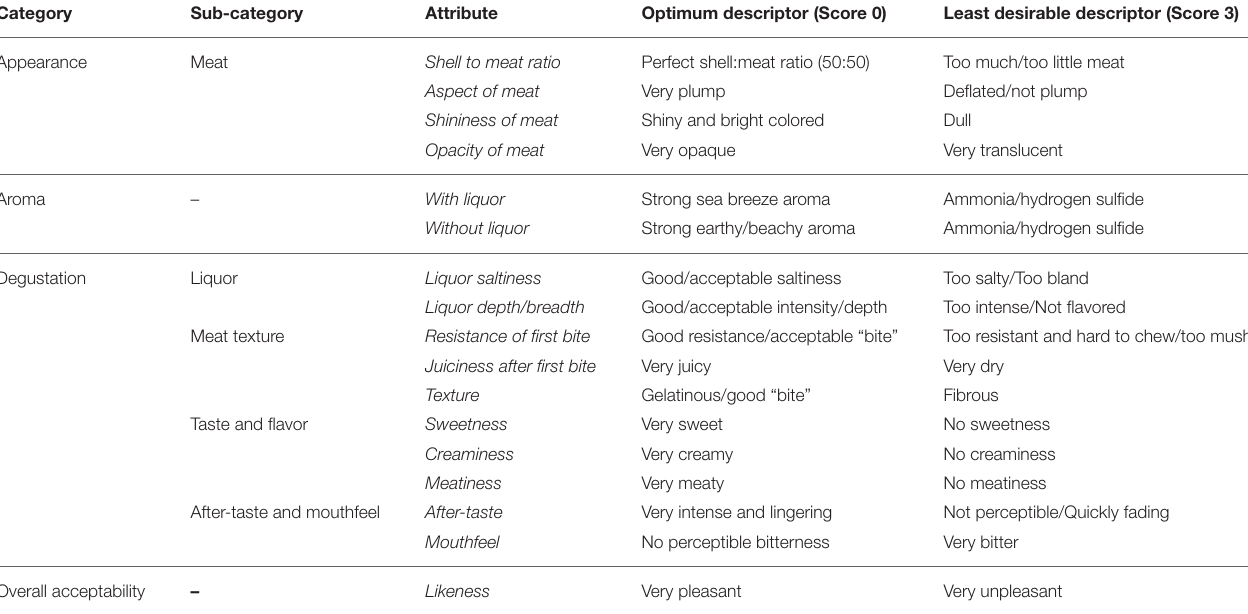
TABLE 2 | Assessment categories and attributes selected during the focus session and used for the sensory analysis, along with the extreme descriptors.